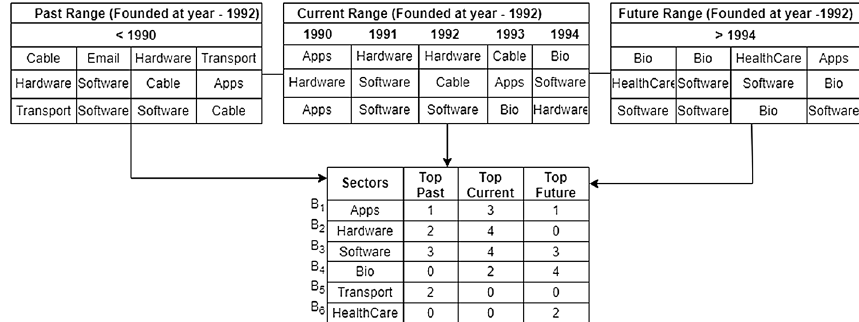
Fig. 11 An example of creating past, current, and future ranges for market features. The top-middle table refers to top business sections at the “current” (i.e. 1990–1994). The top-left table refers to top business sections during the “past” (i.e. before 1990). The right-left table refers to top business sections in the “future” (i.e. after 1994). The table at the bottom shows number of times a sector tag appears in the companies with respect to “past”, “current”, and “future”, respectively. For example, hardware tag appeared in two sponsored companies in the past, and appeared in four sponsored companies at the current